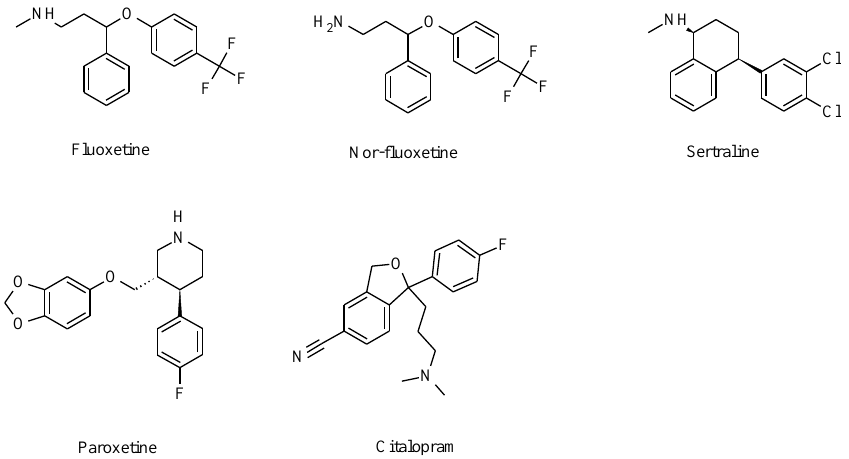
Figure 1. Molecular structures of clinically used selective serotonin reuptake inhibitors (SSRIs) that also inhibit various nicotinic acetylcholine receptor (nAChR) subtypes.